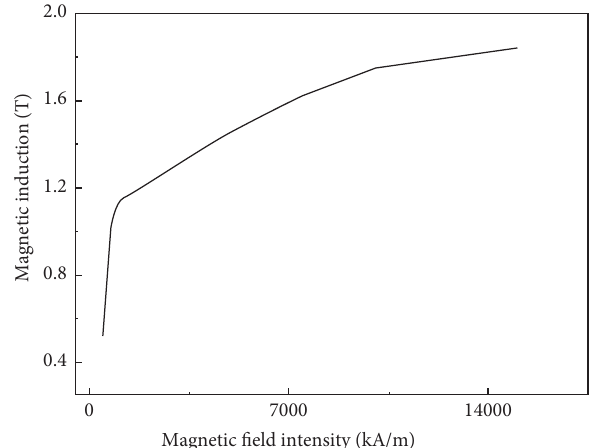
Figure 2: Magnetization curve of #45 steel.